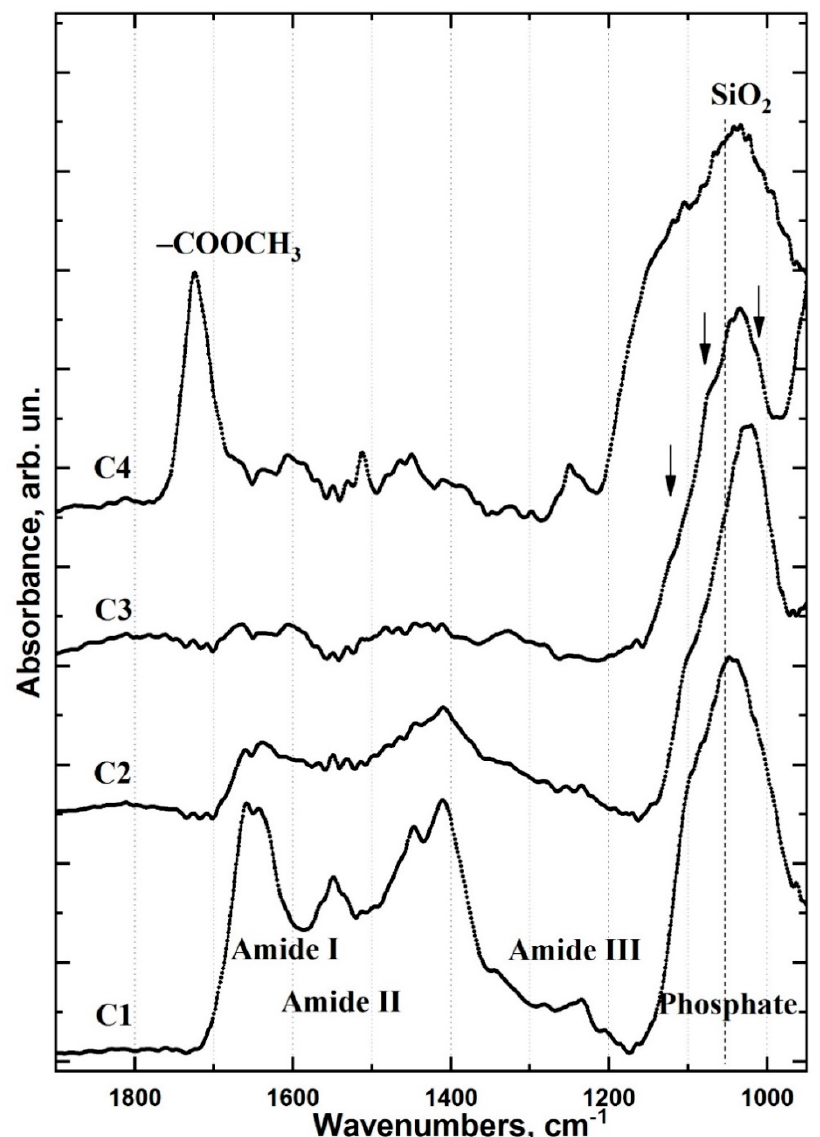
Figure 5. FTIR spectra of type I specimen clusters that are referred to colour-coded clusters C1–C4 for type I specimens in Figure 4a: (C1) FTIR spectrum of type I C1 cluster (healthy dentine); (C2) FTIR spectrum of type I C2 cluster (partially demineralised/disorganised dentine); (C3) FTIR spectrum of type I C3 cluster (laser-treated dentine); (C4) FTIR spectrum of type I C4 cluster (adhesive and dental material in the interface zone).